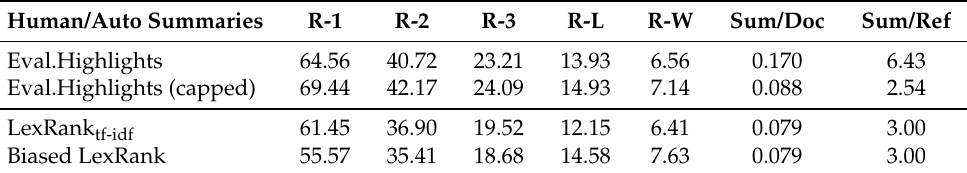
Table 7. Average length statistics and ROUGE F1-scores of the extractive summaries generated using the human evaluators’ highlights and the automatically generated extractive summaries versus the reference abstractive summaries. The second row represents the evaluators’ highlights summaries truncated to three-times the length of the reference summary, matching the extractive summaries in Table 4. The last two columns present the token-level length statistics of the summaries compared to the Court’s judgment main text and reference summary,